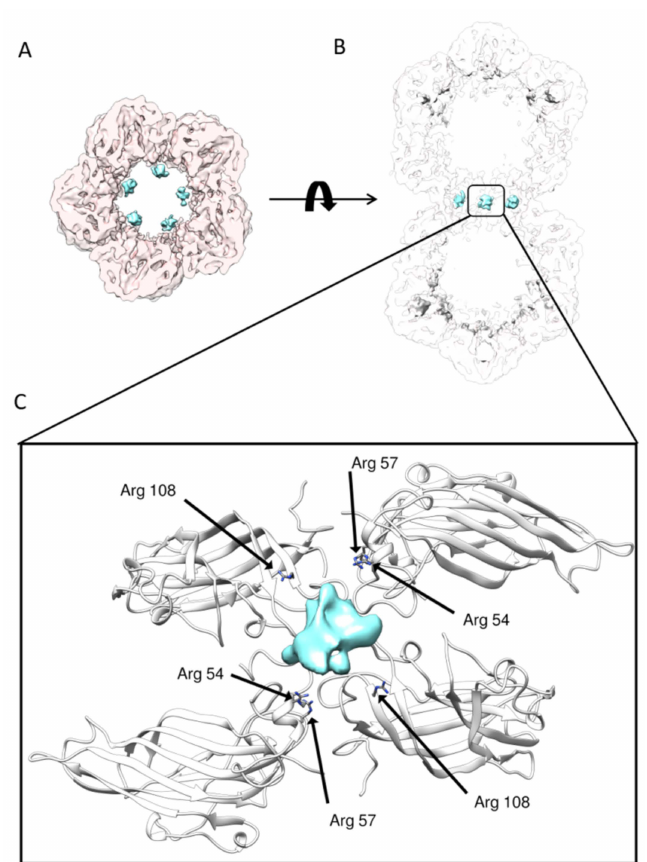
Figure 4. A novel DNA anchoring pocket at the interface: ( A ) extra densities (colored in cyan) are shown at the interface of two hemicapsids; ( B ) vertical slice view of the extra densities at the interface of two hemicapsids; and ( C ) detailed interactions between DNA and the positively charged residues from CP.